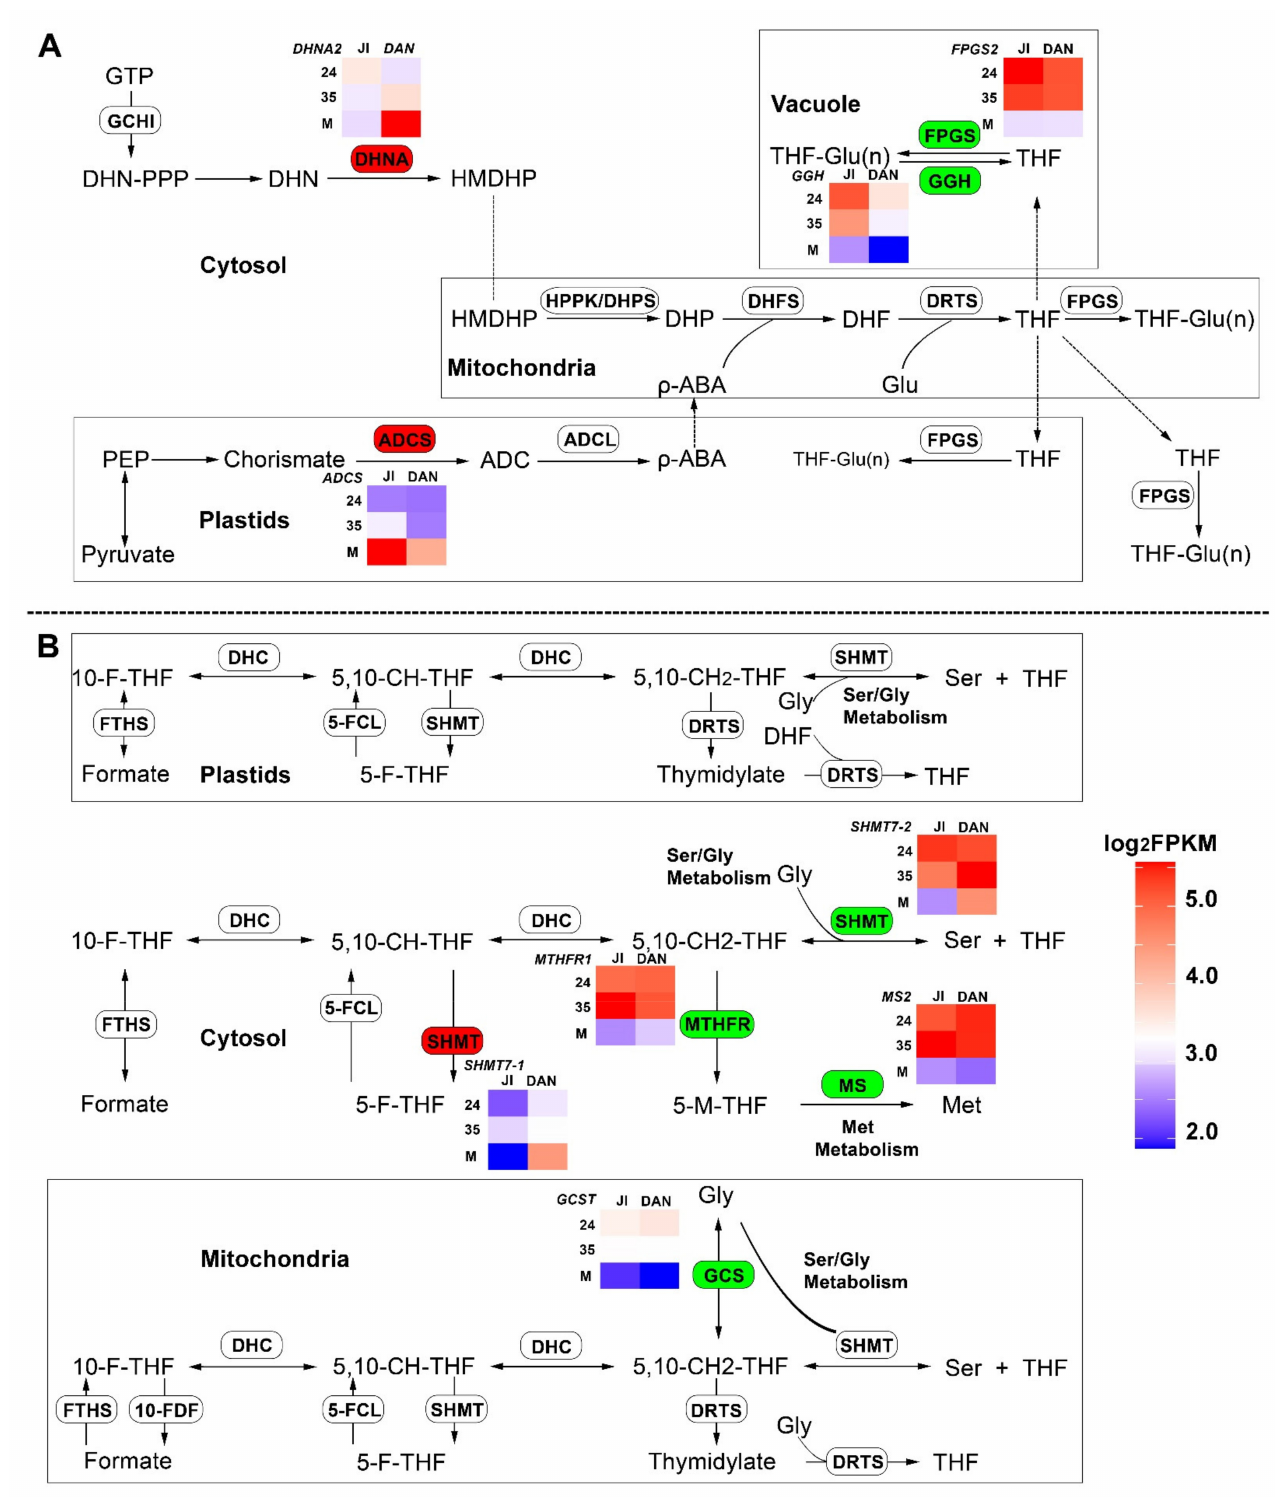
Figure 10. Schematic representation of the folate and one-carbon metabolic reactions in plants. ( A ) Folate biosynthesis pathway; ( B ) One-carbon metabolism pathway. Green, gene shows positive correlation with 5-M-THF; Red, gene shows positive correlation with 5-F-THF. The panel of